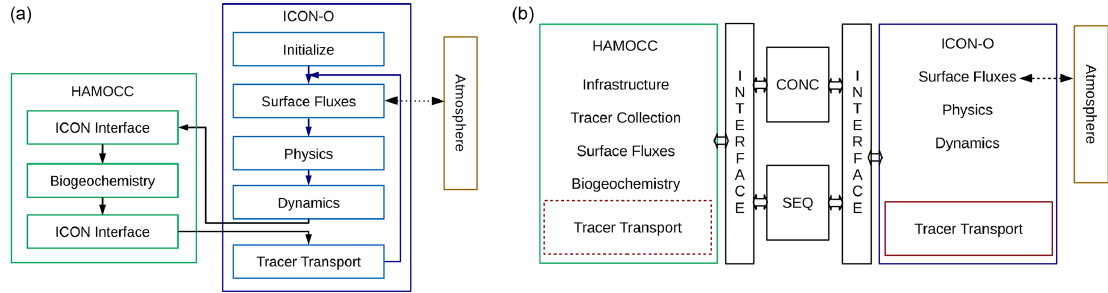
Figure 5. (a) Diagram of the sequential ICON-O–HAMOCC flow. (b) Diagram of the concurrent ICON-O–HAMOCC structure. The same interface is used for both the sequential and the concurrent